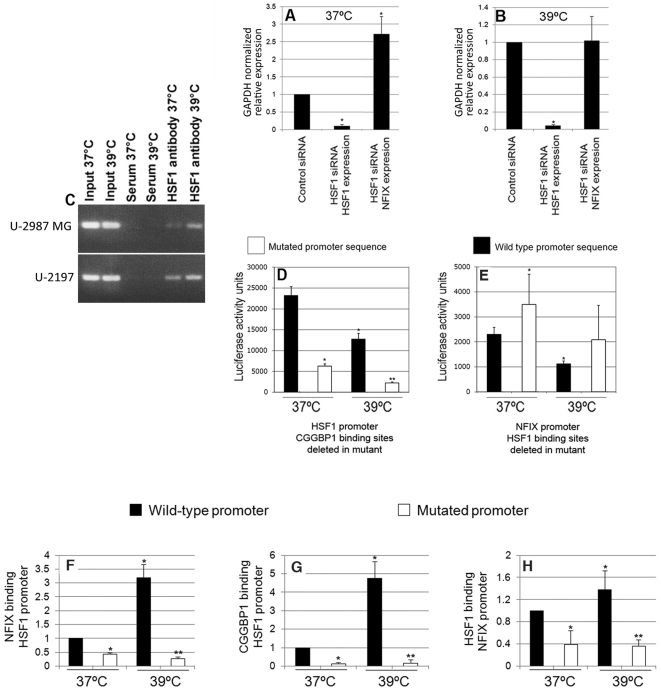
DNA sequence-dependent reciprocal transcriptional regulation between NFIX and HSF1.HSF1-siRNA increases NFIX expression in U-2987 MG cells at 37°C (A), which is lost at 39°C (B). HSF1 occupies the NFIX promoter in a heat shock dependent manner (C). High transcriptional activity of the HSF1 promoter is reduced strongly by both heat shock and loss of CGGBP1 binding sites (D). The NFIX promoter loses its transcriptional activity at 39°C significantly compared to 37°C and mutation of putative HSF1 binding sites causes increased transcriptional activity which is not significantly affected by heat shock (E). NFIX binding on the HSF1 promoter is increased by heat shock and this is lost by mutation of CGGBP1 binding site (F). Heat shock induced CGGBP1 binding is similarly affected by loss of its binding sites in the HSF1 promoter (G). HSF1 binding on the NFIX promoter is mildly induced by heat shock and mutation of HSF1 binding site reduces this binding (H). For all luciferase assays, HEK 293T cells have been used. Asterisks indicate significant change in expression (p<0.05) compared to control-siRNA-37°C in A and B, and, compared to wild-type promoter construct at 37°C in all other cases. Double asterisks indicate significant change compared to wild-type construct at 39°C. All values except D and E are average ±S.D. of ratios calculated by delta-delta Ct method using GAPDH or wild-type-37°C values as internal control. For the control-siRNA-37°C or wild-type construct-37°C, the value is this normalized to 1 in each case, so no S.D. is shown. In A and B, baseline values for HSF1 and NFIX using control-siRNA is shown by a single bar as the normalized value is 1 for both cases.